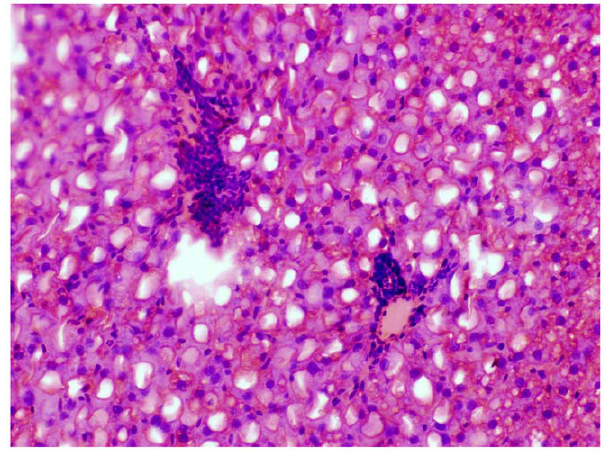
Figure 7. Liver injury group C. Focal parenchymal loss and haemorrhage in the liver of an animal in group C.